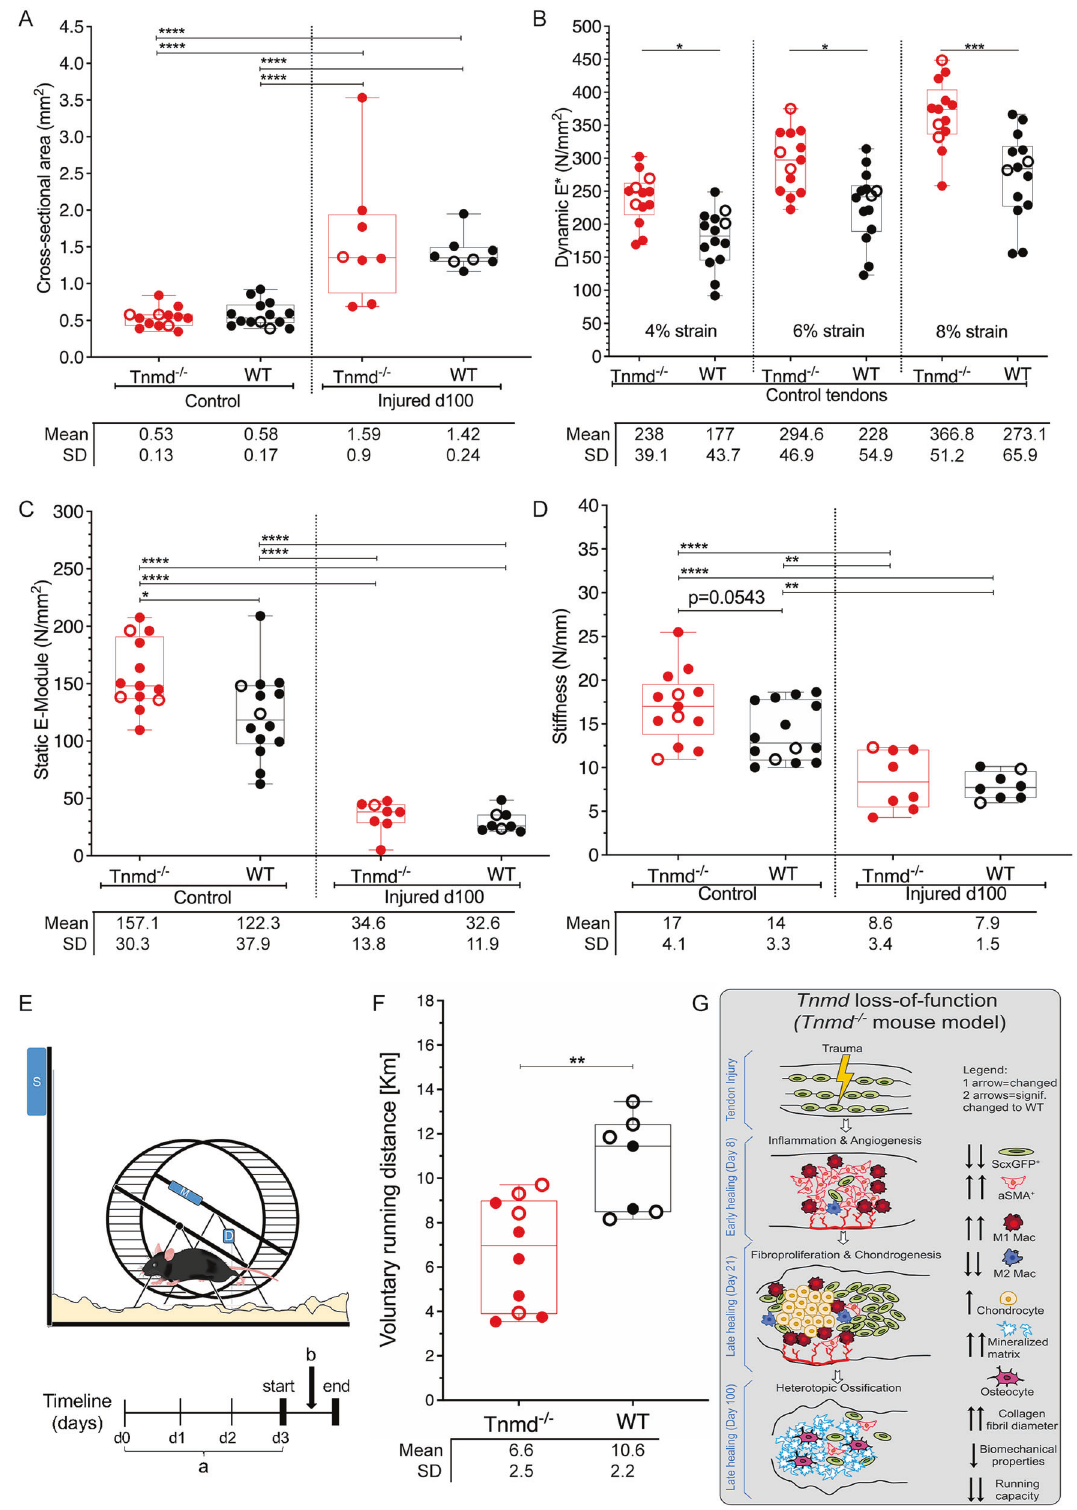
Fig. 5 Viscoelastic biomechanical testing of non-injured, control and injured Achilles tendons, and voluntary running tests at day 100 post-injury. A Cross-sectional area of non-injured, control and injured Achilles tendons. B Dynamic Elastic modulus in control Achilles tendons at 4%, 6% and 8% strain. C Static Elastic modulus and D stiffness of non-injured, control and injured Achilles tendons. Biomechanical testing was performed with n = 8 – 14 animals/genotype. Box plots show median ± IQR; statistical analysis was performed with one-way ANOVA and Bonferroni post-hoc test. E Test setup (upper drawing) and timeline (bottom drawing) for voluntary running tests. F Recorded running distance; tests were performed with n = 7 – 10 animals/genotype. Box plots show median ± IQR; statistical signi fi cance assessed with 2-tailed unpaired parametric Student ’ s t -test, * p < 0.05, ** p < 0.01, *** p < 0.001, **** p < 0.0001. Empty dots represent female mouse; fi lled dots represent male mouse. G Graphical synopsis of the major phenotypic changes in Tnmd − / − animals over the time course after